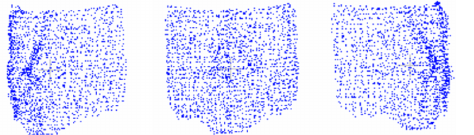
Figure 7. 2D images extracted from the final face clouds for Marker 1 without texture mapping proposed by this